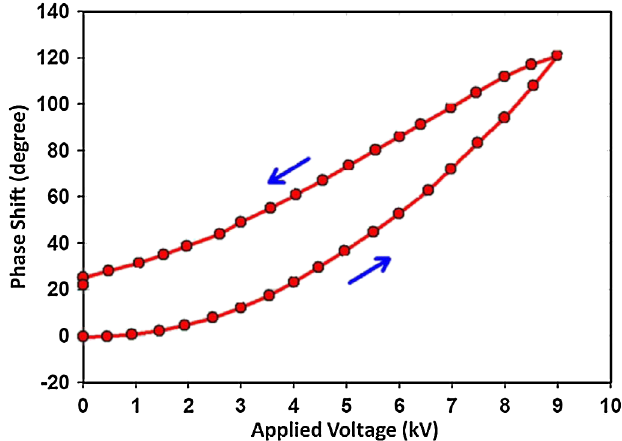
FIG. 9. Measured phase shift of rf signal transmitted through one-third section vs applied bias